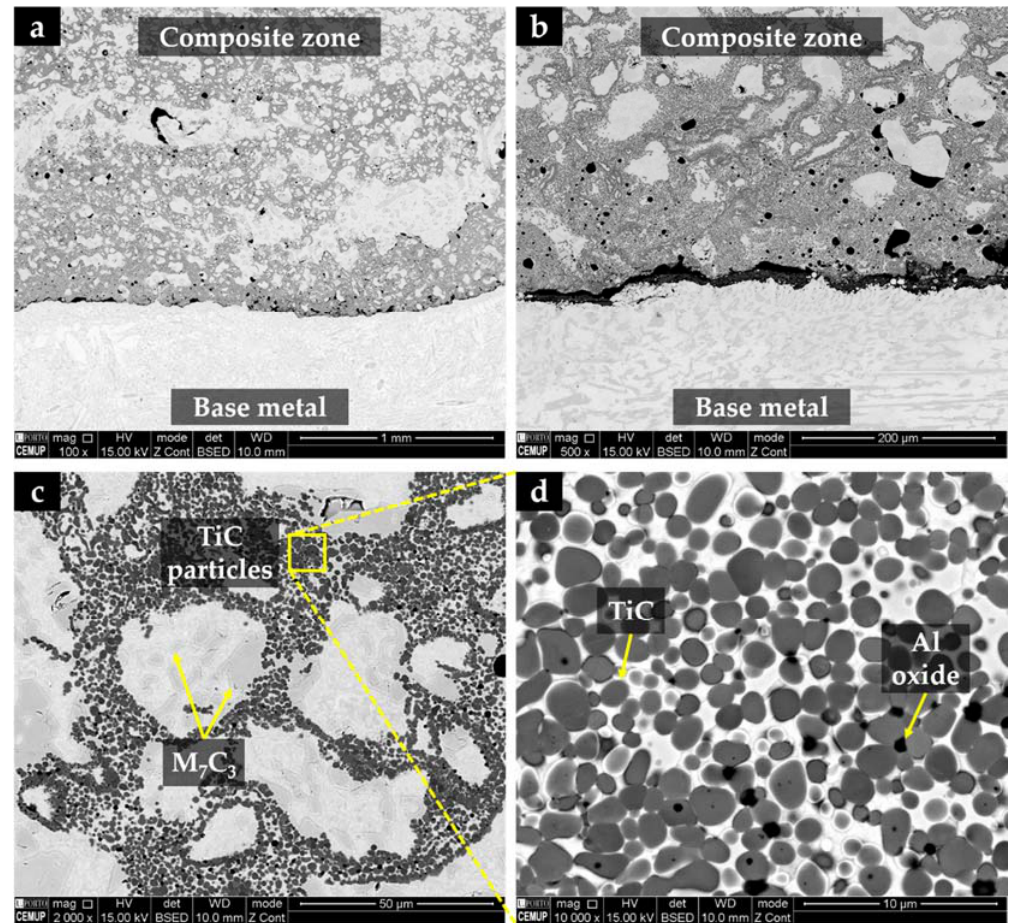
Figure 4. SEM-BSE images of the TiC-WCI reinforcement: ( a ) base metal and composite zone, ( b ) interface at higher magnification, ( c ) composite zone at higher magnification, and ( d ) TiC particles, showing a round morphology.